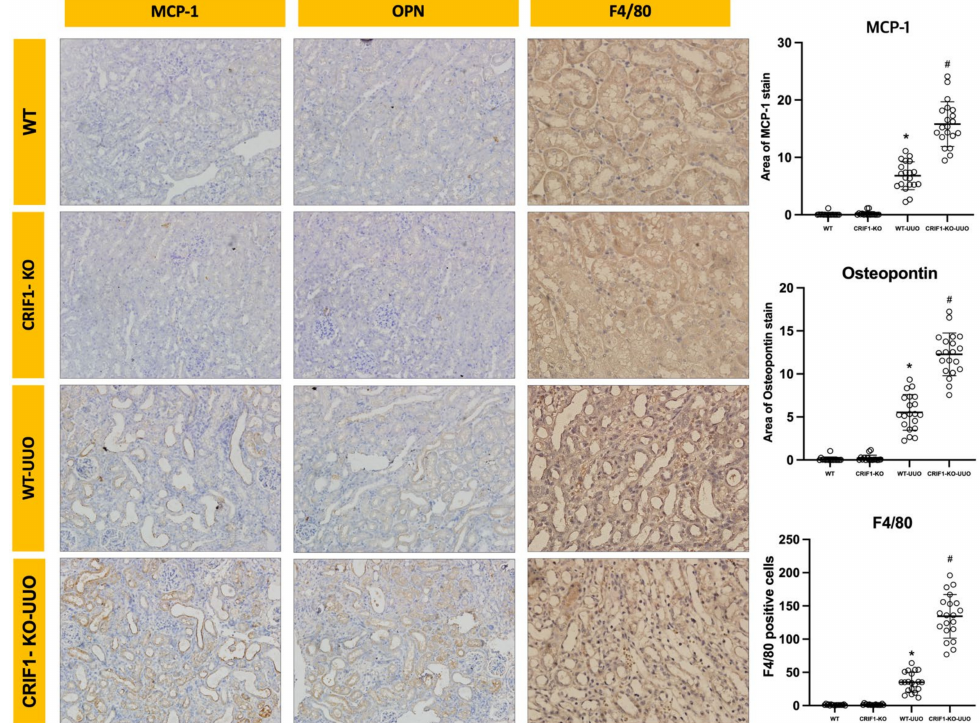
Figure 6. Photos of immunohistochemical stain of MCP-1, osteopontin (OPN), and F4/80. CR6- interacting factor-1 knockout (CRIF1-KO)-unilateral ureteral obstruction (UUO) kidneys showed an increase in the stained areas of MCP-1 and OPN and the number of F4/80-positive cells compared with wild-type (WT)-UUO kidneys. * p < 0.05, WT-sham vs. WT-UUO; # p < 0.05, WT-UUO vs.